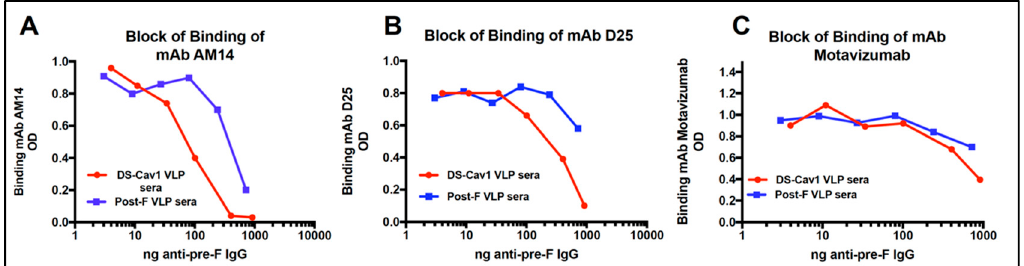
Figure 7. Amounts of polyclonal antibody that blocks binding of representative mAb. Shown is the ability of anti-pre-F IgG in DS-Cav1 VLP sera and in Post-F VLP sera to block binding of mAb to soluble DS-Cav1 targets. Results are plotted as binding of the 200 ng of mAb in the presence of increasing amounts (ng/mL) of anti-pre-F IgG in each pooled serum. Binding of mAb is detected using anti-human IgG coupled to HRP, as described in Materials and Methods. Panel A shows the inhibition of binding of mAb AM14 with different amounts of anti-pre-F IgG. Panel B shows inhibition of binding of mD25. Panel C shows inhibition of binding of motavizumab. Red, DS-Cav1 VLP sera; Blue, Post-F VLP sera.